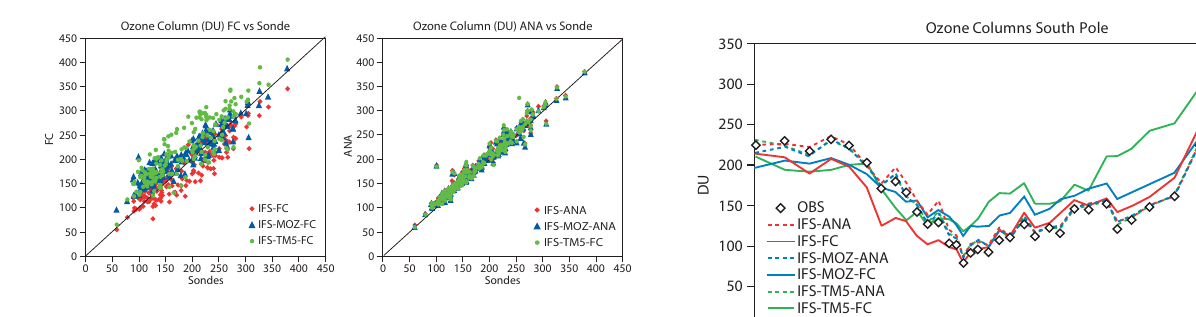
Fig. 5. Columns of ozone soundings at different locations (OBS, see Table 3) in the period from 1 August to 31st of December 2008 and the corresponding predictions for the first forecast day by IFS- MOZART (blue triangle), IFS-TM5 (green circle) and IFS (red dia- mond) without assimilation (FC, left) and with assimilation (ANA, right).